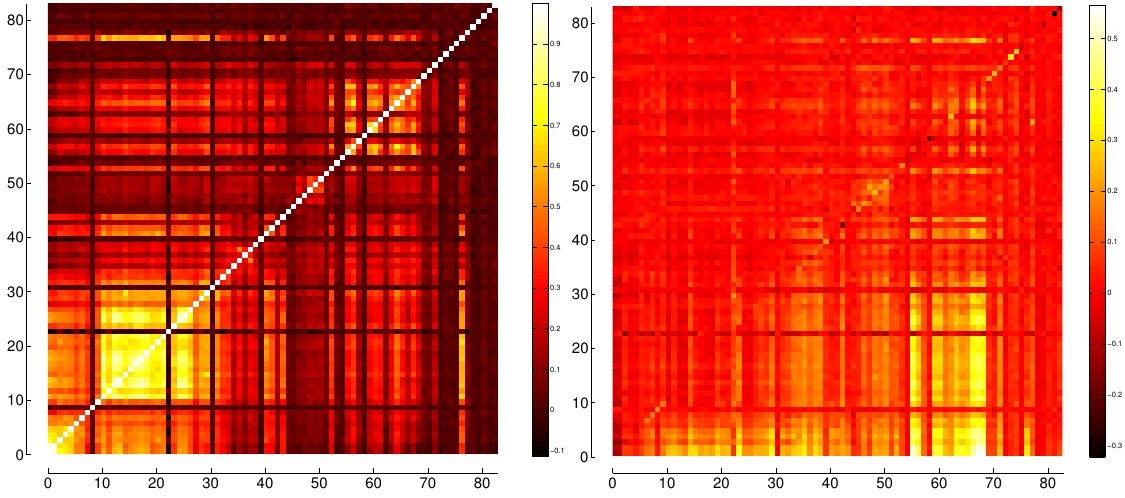
Figure 19. Heat maps of the correlation and lagged correlation matrices for the absolute values of log returns.